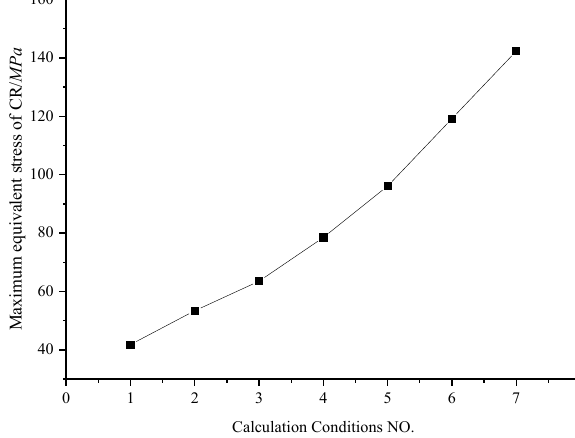
Figure 40. Radial deformation Ux of CR under various calculation conditions in local coordinate system. The maximum equivalent CR stress curve under various tension calculation conditions is shown in Figure 41. It can be found that with increased tension force of the tie-downs, the stress of the CR resulting from the radial cable force gradually increases. The maximum equivalent stress value reaches 145.3 MPa when the tensioning of tie-downs is completed. The stress level of CR is acceptable.